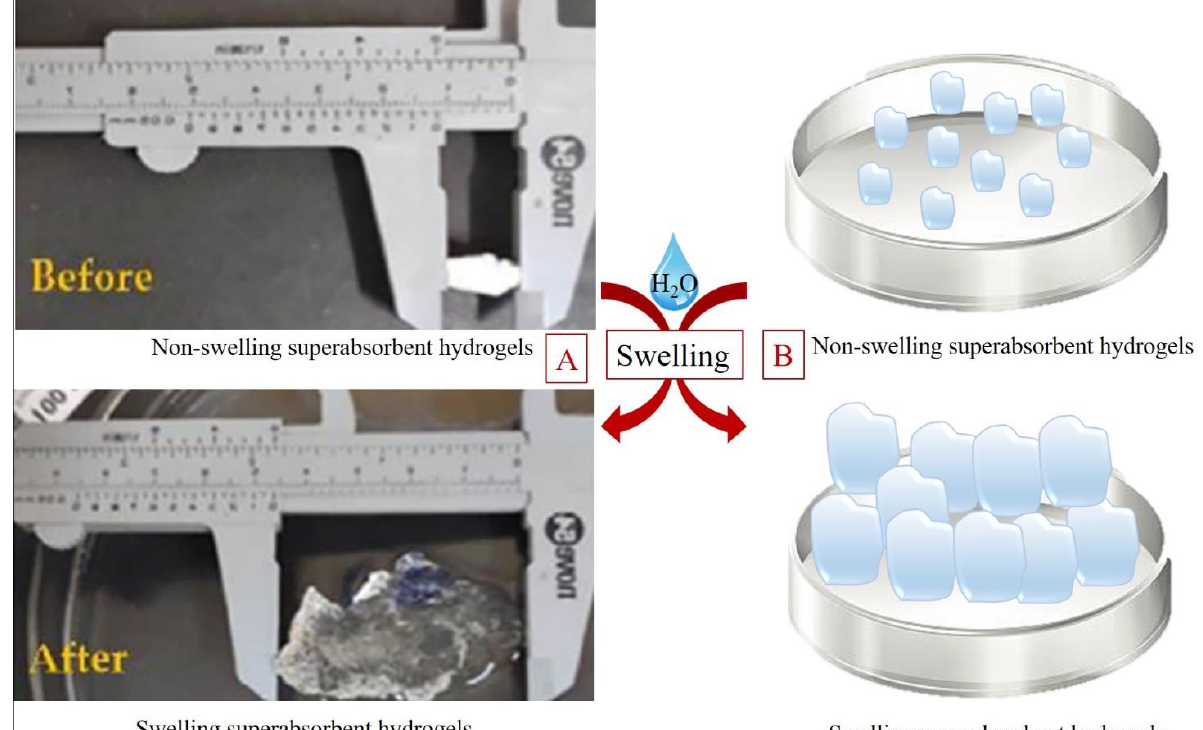
Figure 6. Swelling behavior of superabsorbent hydrogels (SAH) in a real sample ( A ) [106] and schematically ( B ).